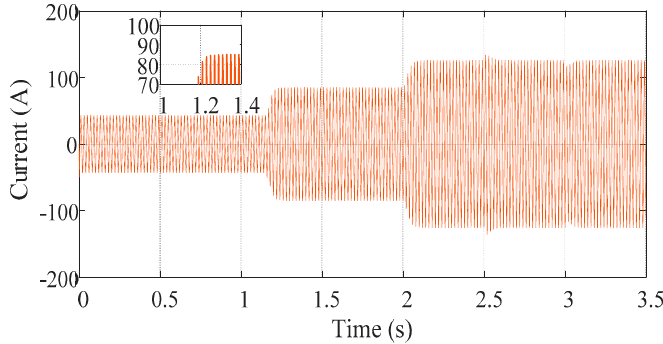
Figure 18. Output current (Phase A) of LADRC-VSG.